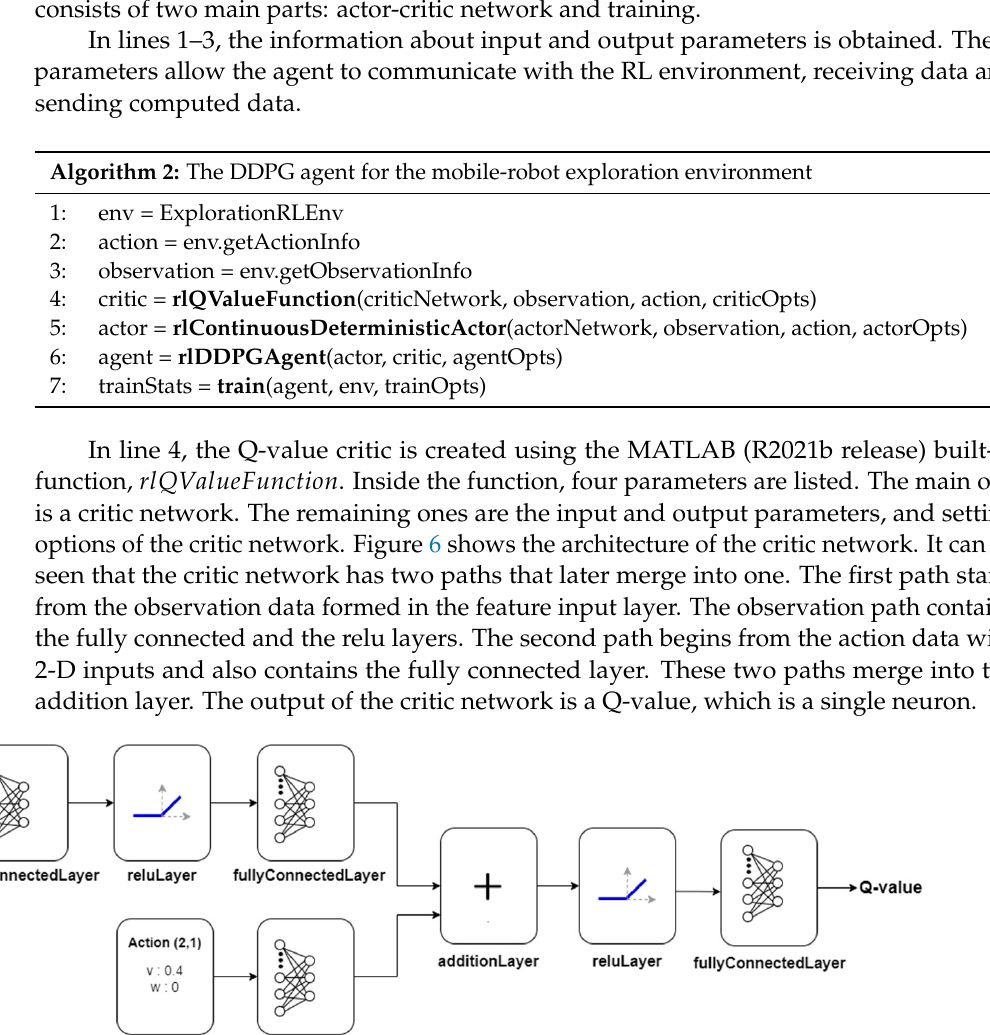
Algorithm 2: The DDPG agent for the mobile-robot exploration environment